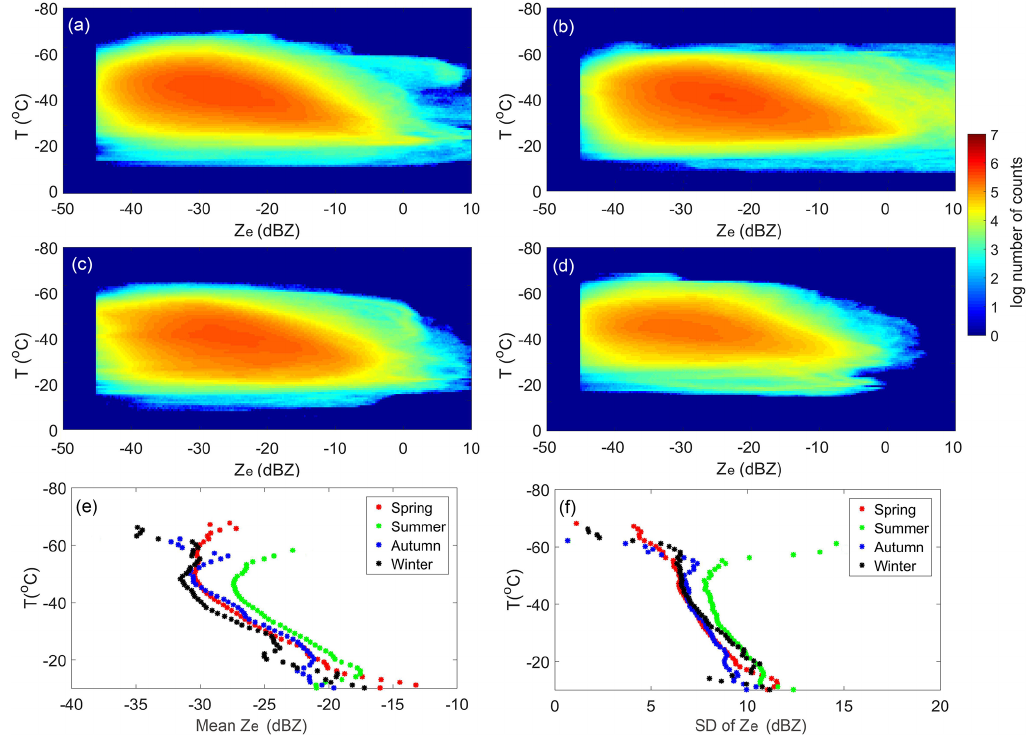
Figure 6. As in Fig. 5 but for temperature, and the colors are the log number of the counts (calculated at 0.25dBZ and 1 ◦ C intervals).